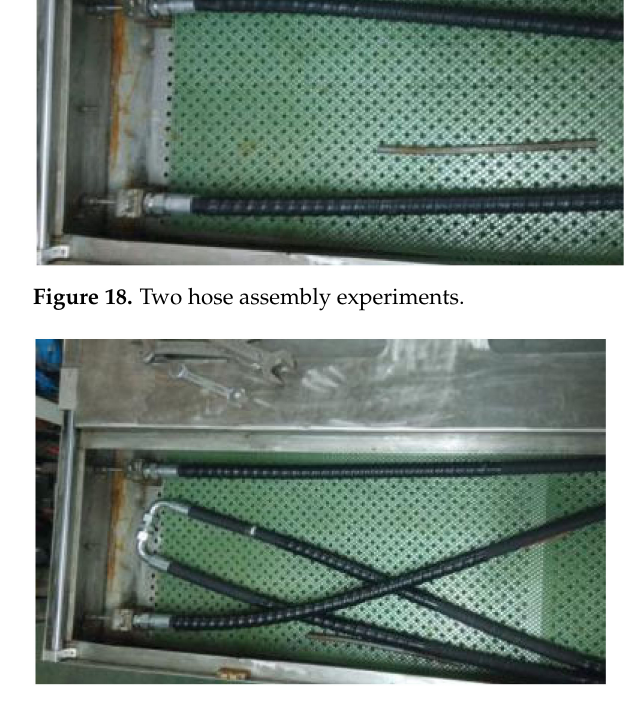
Figure 19. Four hose assembly experiments.